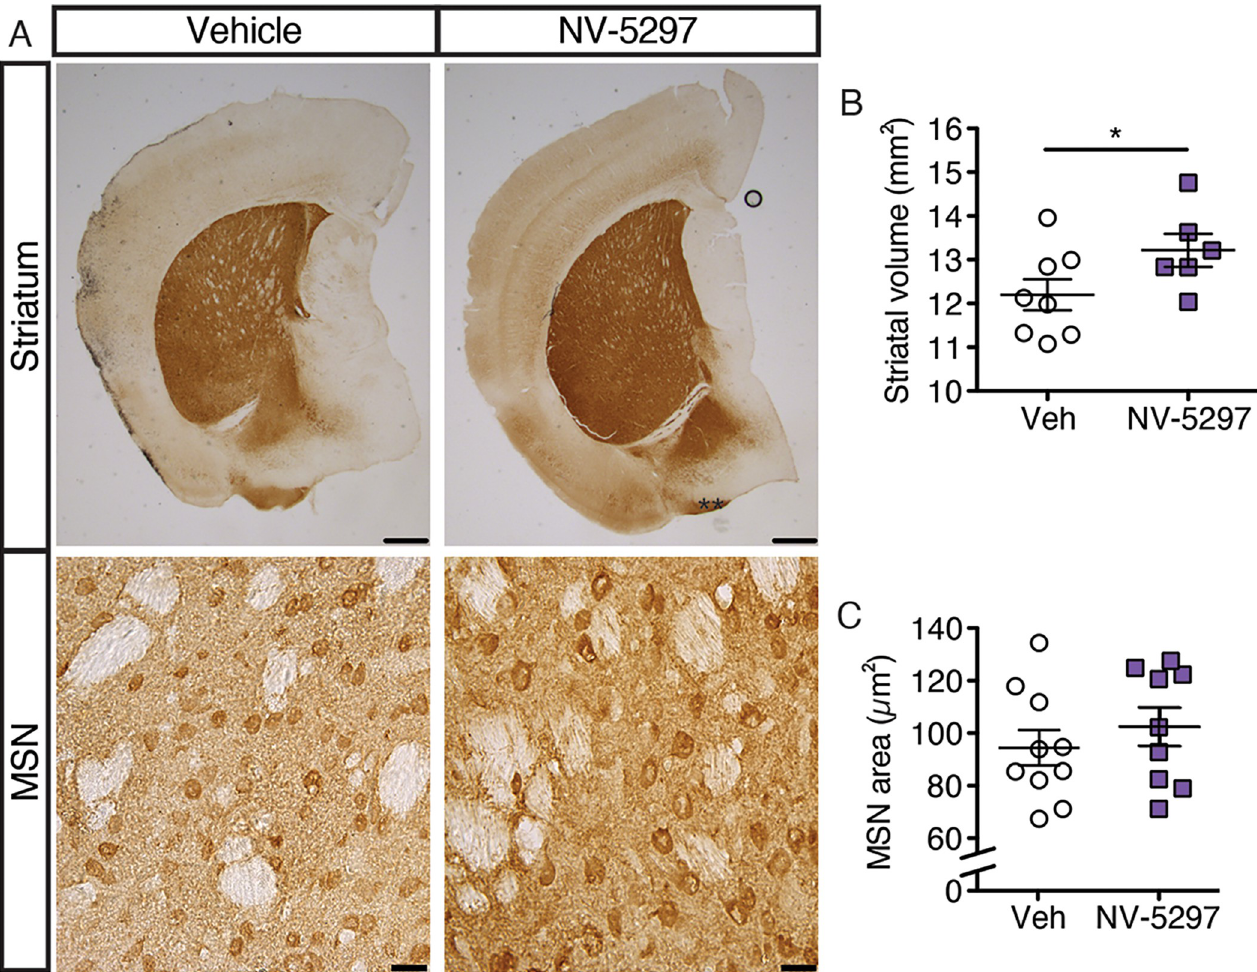
Fig 4. Daily oral dosing of NV-5297 over 6 weeks protects the striatum in N171-82Q males. (A) Representative immunohistochemical staining of Medium Spiny Neurons (MSN) with anti-DARPP-32 in 12 weeks old N171-82Q males. Scale bars striatum: 500 μ m. Scale bars MSN: 20 μ m. Quantification of striatal volumes (n = 8 Vehicle [Veh], n = 6 NV-5297) (B) and MSN cell area (Veh n = 9, NV-5297 n = 9) (C). Data are presented as mean ± SEM. � P � 0.05 (unpaired one-tailed Student’s t-tests).